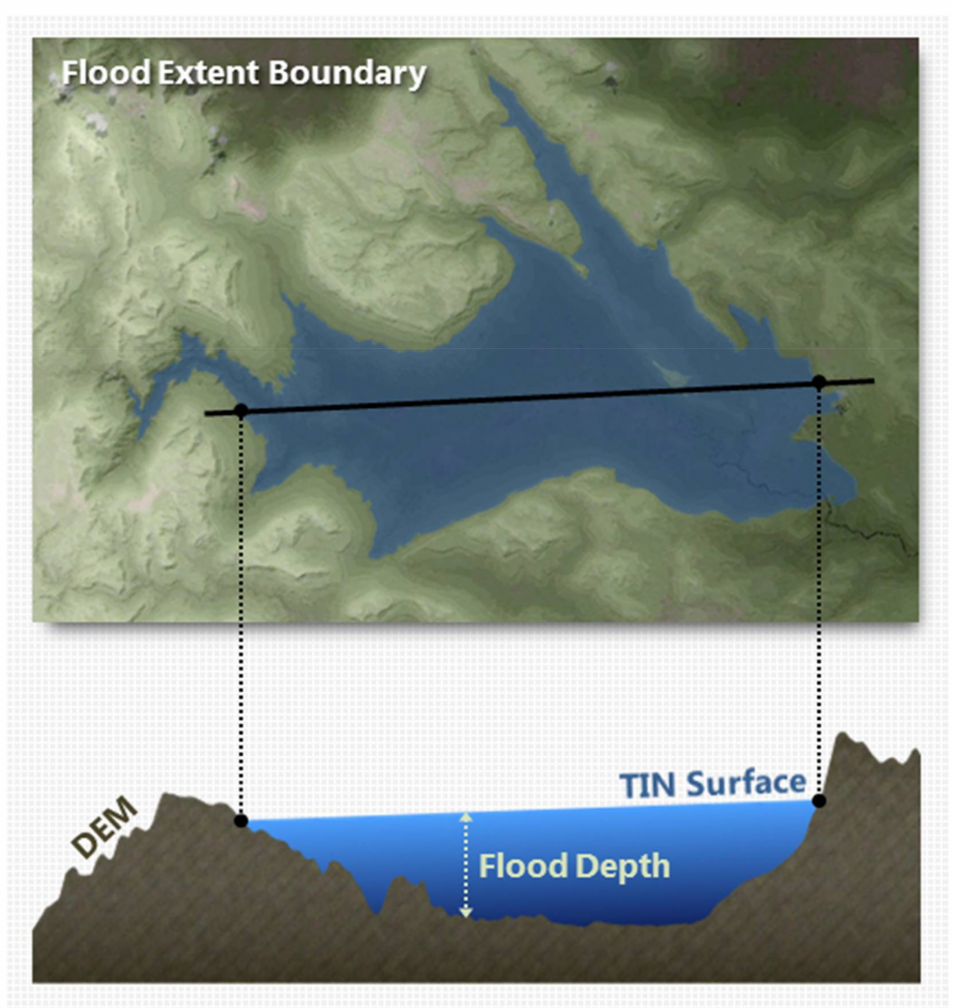
Figure 2. Plan view ( upper ) and cross-section schematic ( lower ) illustrating flood depth estimation using inundation extent. Figure adapted from Cham et al. (2015) [41]. DEM = digital elevation